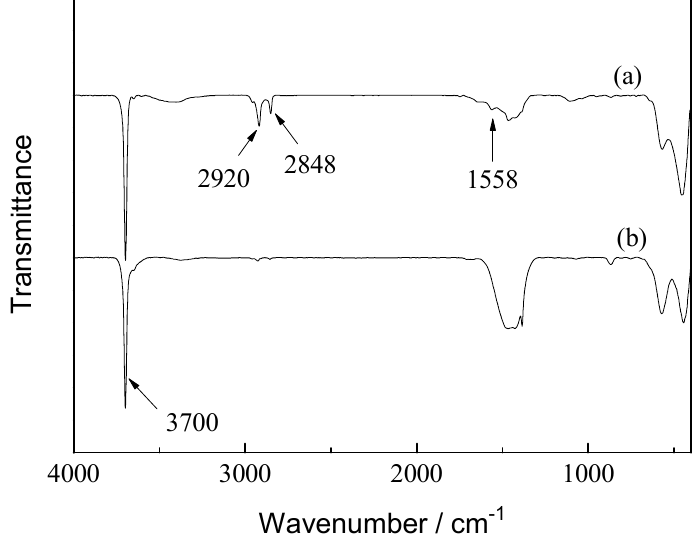
Coatings 2019 , 9 , x FOR PEER REVIEW Figure 9. X-ray di ff ractometer (XRD) spectra of typical samples: ( a ) CD + HT; ( b ) CD. Figure 9. X-ray diffractometer (XRD) spectra of typical samples: ( a ) CD + HT; ( b ) CD.